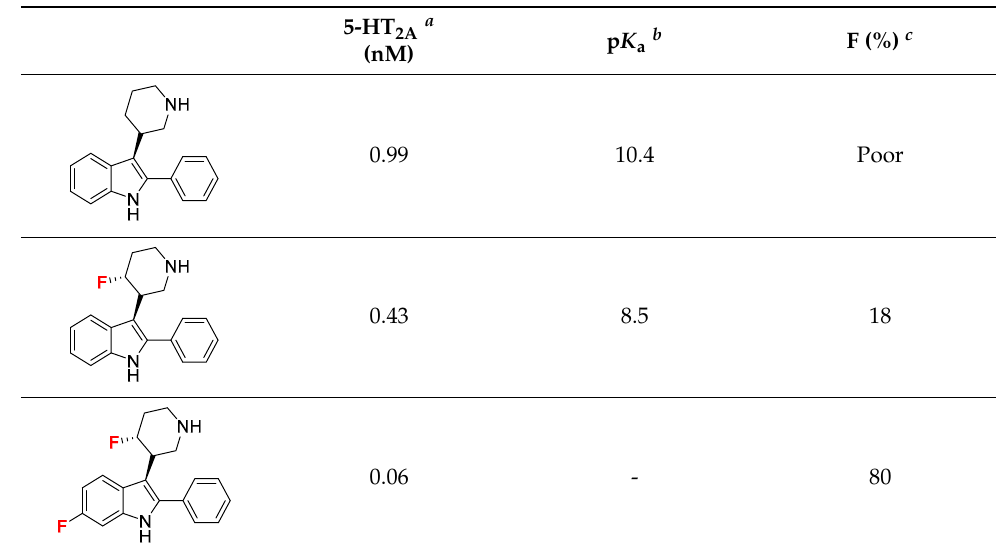
Table 1. Effect of fluorine on a 3-piperidinylindole series endowed with antipsychotic activities. a Affinities at a human-cloned 5-HT 2A receptor. b Acid dissociation constant for the piperidinic-NH. c Bioavailablity (%) in rats.